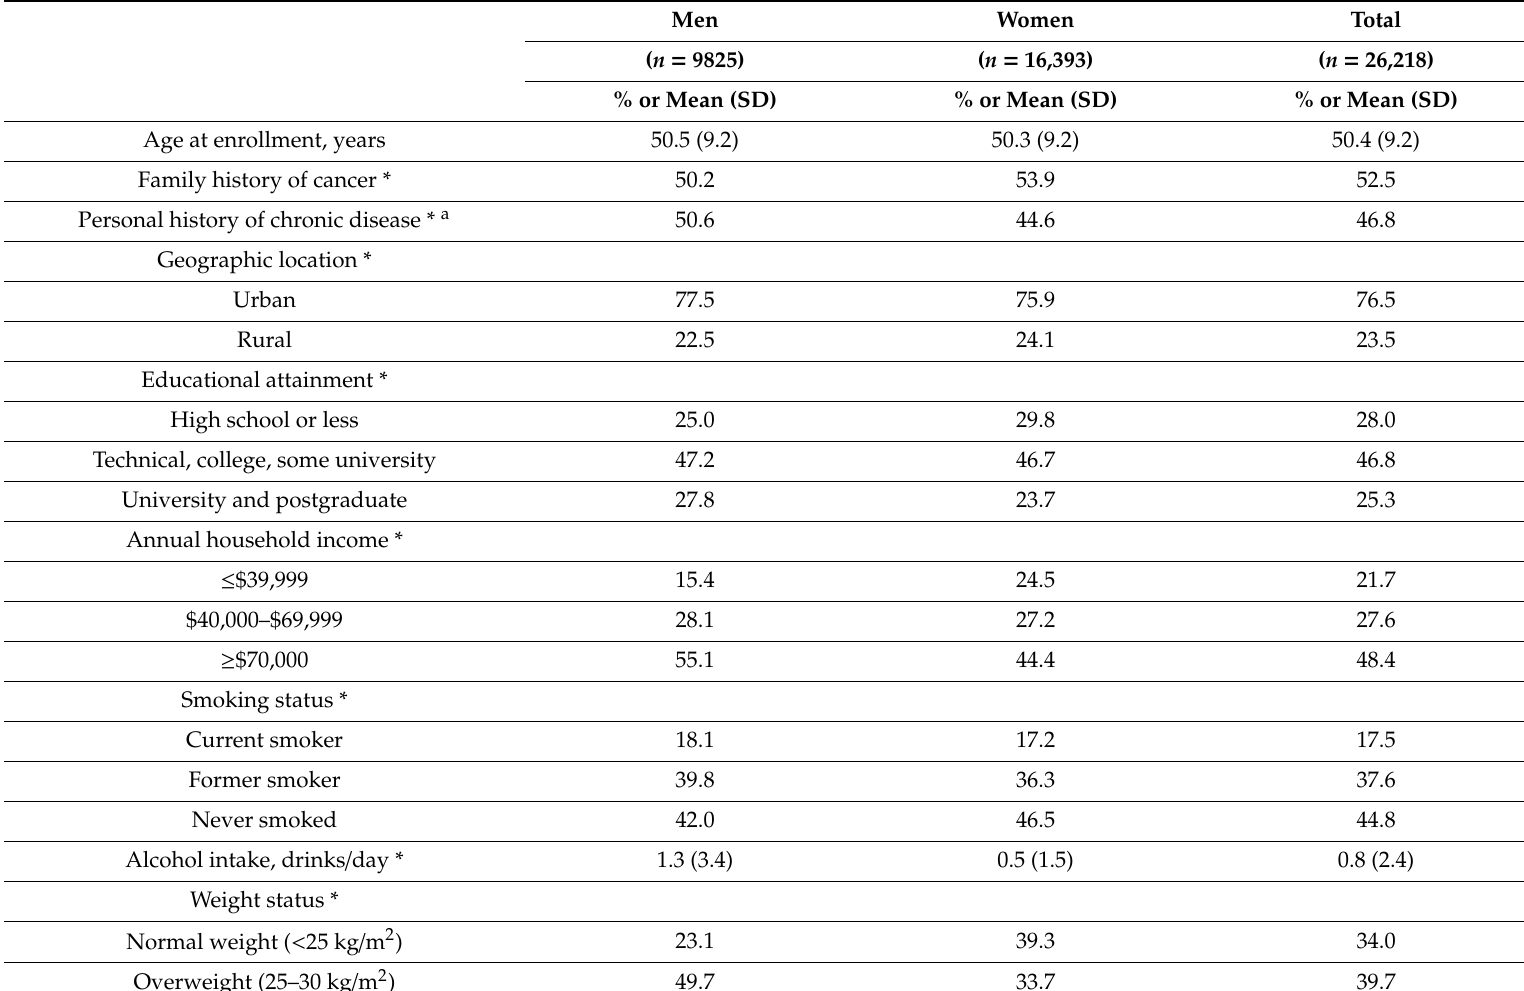
Table 1. Baseline characteristics of Alberta’s Tomorrow Project participants by gender ( n =